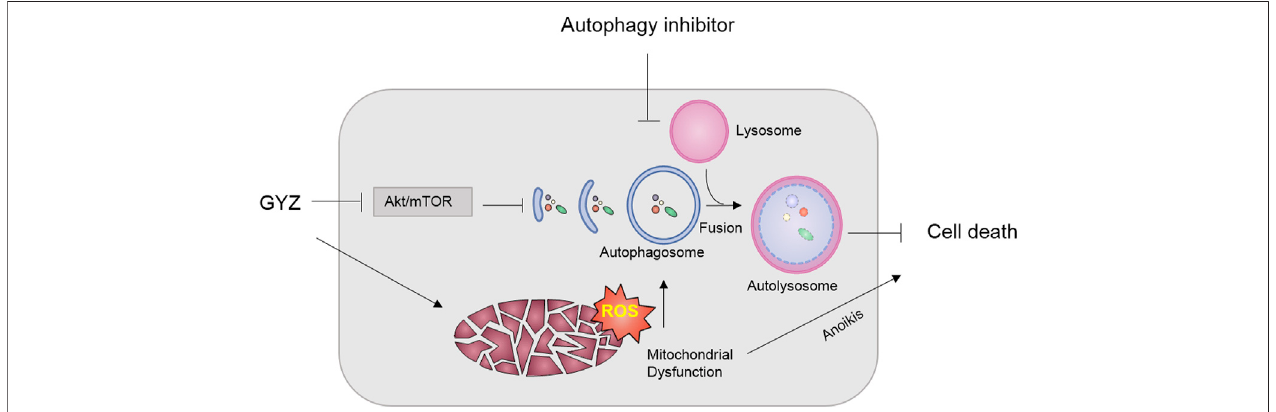
FIGURE 9 | Schematic illustrating the mechanism of GYZ treatment accompanied with autophagy inhibition in NSCLC. On the one hand, GYZ induced mitochondrial dysfunction and increased the ROS level, thereby triggering anoikis in NSCLC; On the other hand, GYZinduced theformation ofautophagosome and the fusion and degradation of autolysosome by blocking Akt/mTOR axis, resulting in cytoprotective autophagy and impaired anti-tumor effects of GYZ. Therefore, co-treatment with autophagy inhibitors could enhance the anti-tumor effects of GYZ in NSCLC.